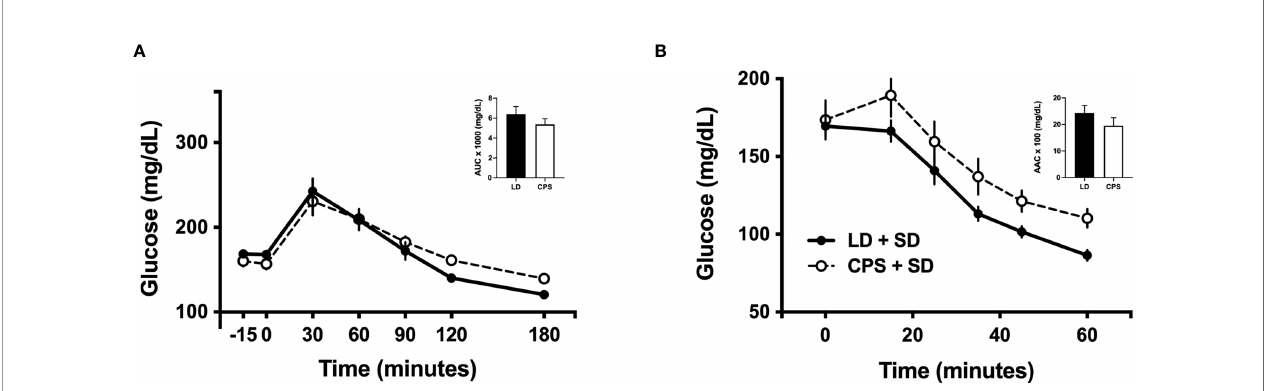
FIGURE 4 | Effects of gestational chronic phase shift of photoperiod on intraperitoneal glucose tolerance test (A) and intraperitoneal insulin tolerance test (B) of rats fed with standard diet (SD) since 100 to 200 days of age. Data are mean±SEM. Solid line: LD, adult rats that had been gestated under control 12:12 (LD) photoperiod; dashed line: CPS, adult rats that had been gestated under chronic phase shift (CPS) photoperiod; circles: adult offspring fed with standard diet Prolab ® RMH 3000; squares: adult offspring fed with HFD. n = 8 per group.